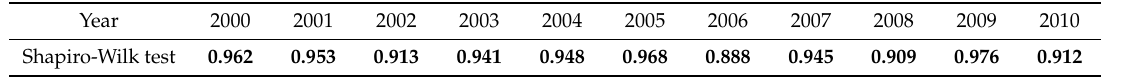
Table A1. Shapiro–Wilk test for normality, bold print if H 0 was accepted at α = 0.05.